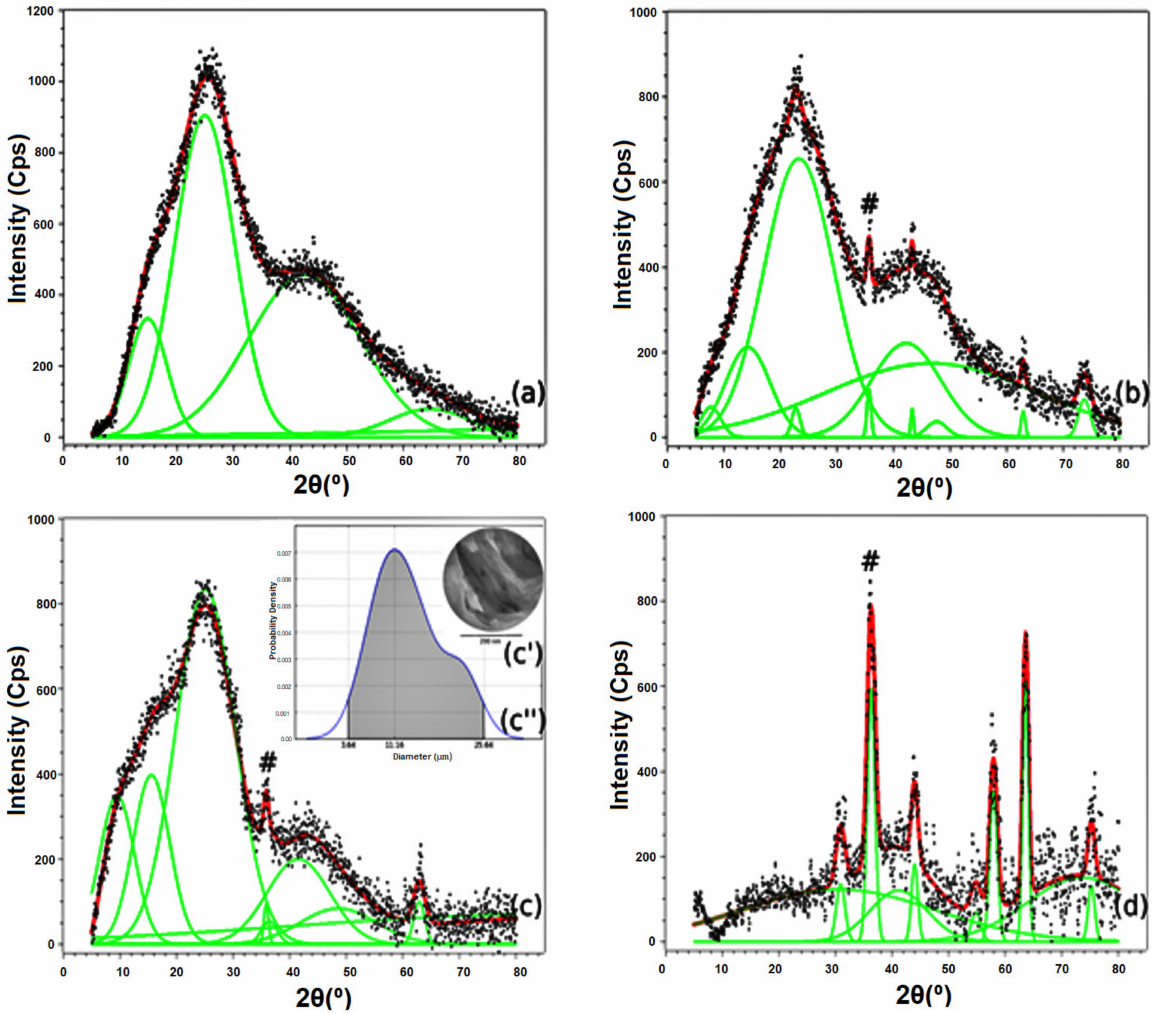
Figure 3. XRD Patterns of resin ( a ), composites filled with 1 wt% ( b ) and 3 wt% of magnetite ( c ) and pure magnetite ( d ). Insets ( c (cid:48) , c” ) are the TEM and probability density function of the sample filled with 3 wt% of magnetite, respectively. The # symbol refers to the peak centered around 35 ◦ , characteristic of the magnetite